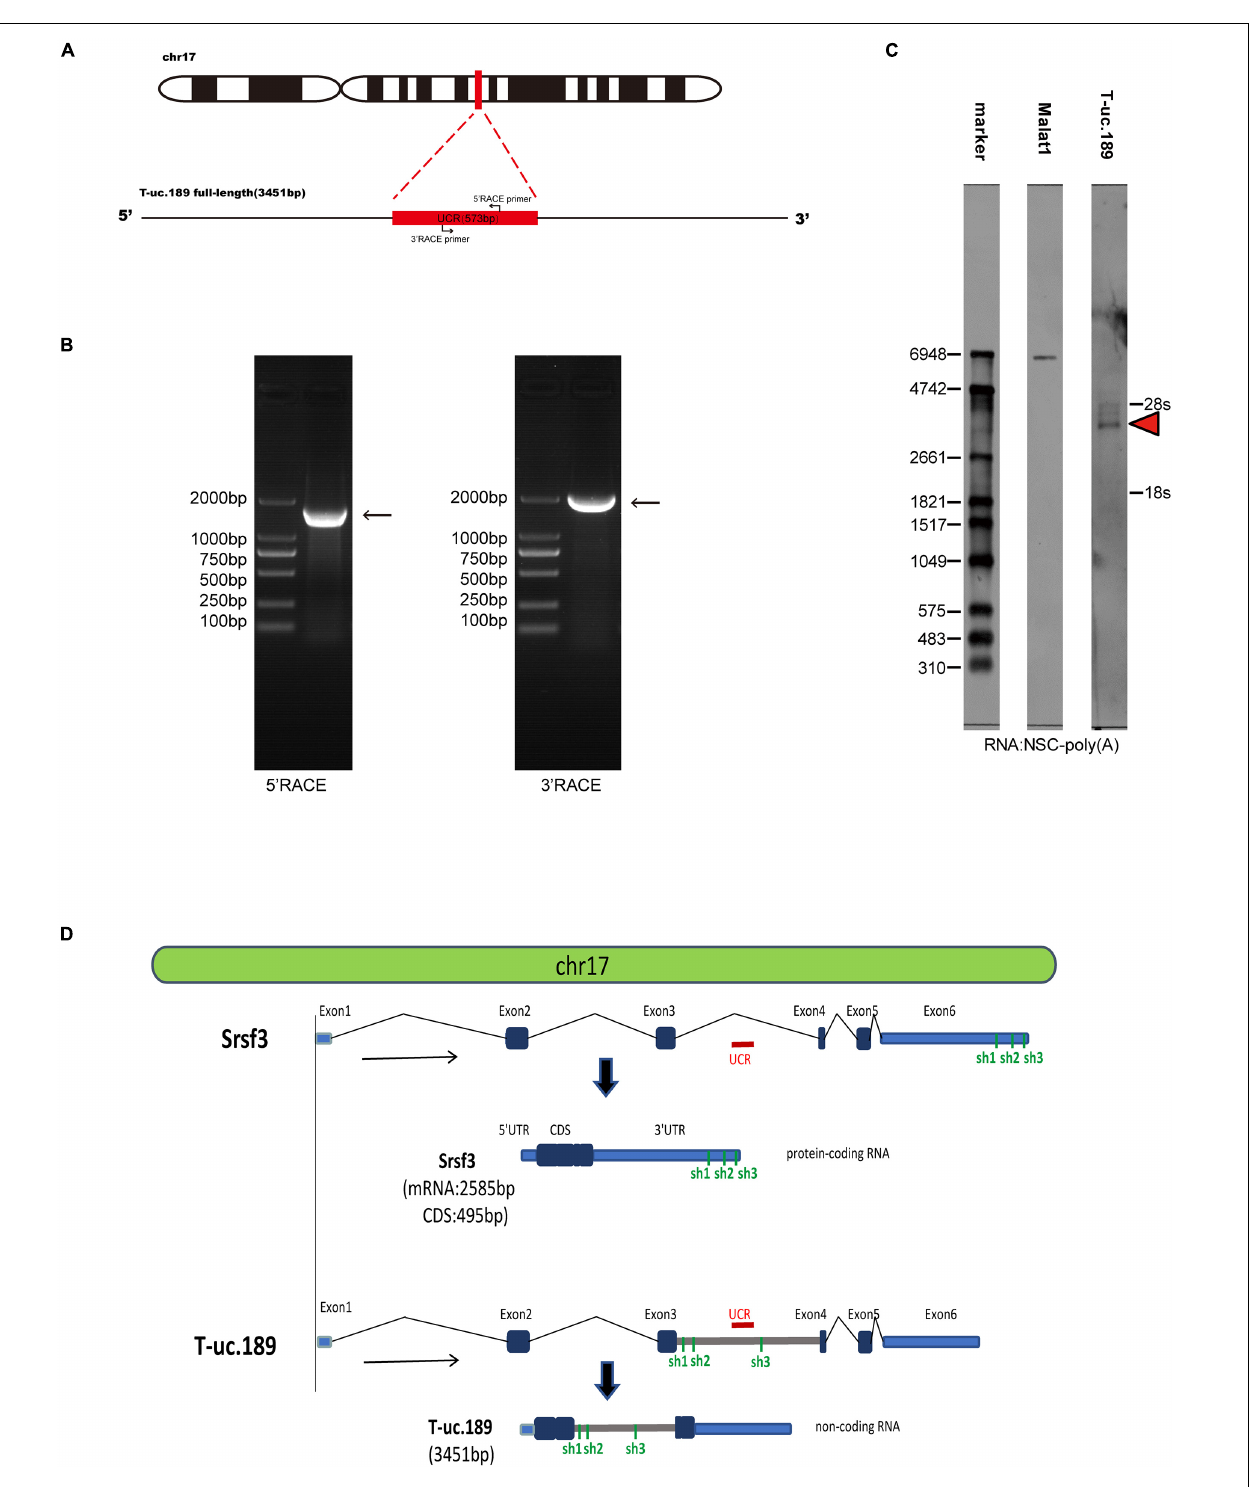
FIGURE 1 | Information regarding the full-length sequence of T-uc.189. (A) Schematic diagrams of the RACE assays. (B) Agarose gel electrophoresis image of the nested PCR products from the 5 (cid:48) - and 3 (cid:48) -RACE assays. (C) Northern blot experiments with total RNA extracted from neural stem cells. The red arrow indicates the RNA signals of T-uc.189. (D) The genomic location of T-uc.189 relative to that of its host gene Srsf3 . The red line indicates the position of the ultra-conserved region of T-uc.189. The green line indicates the position of the shRNA of Srsf3 and T-uc.189.